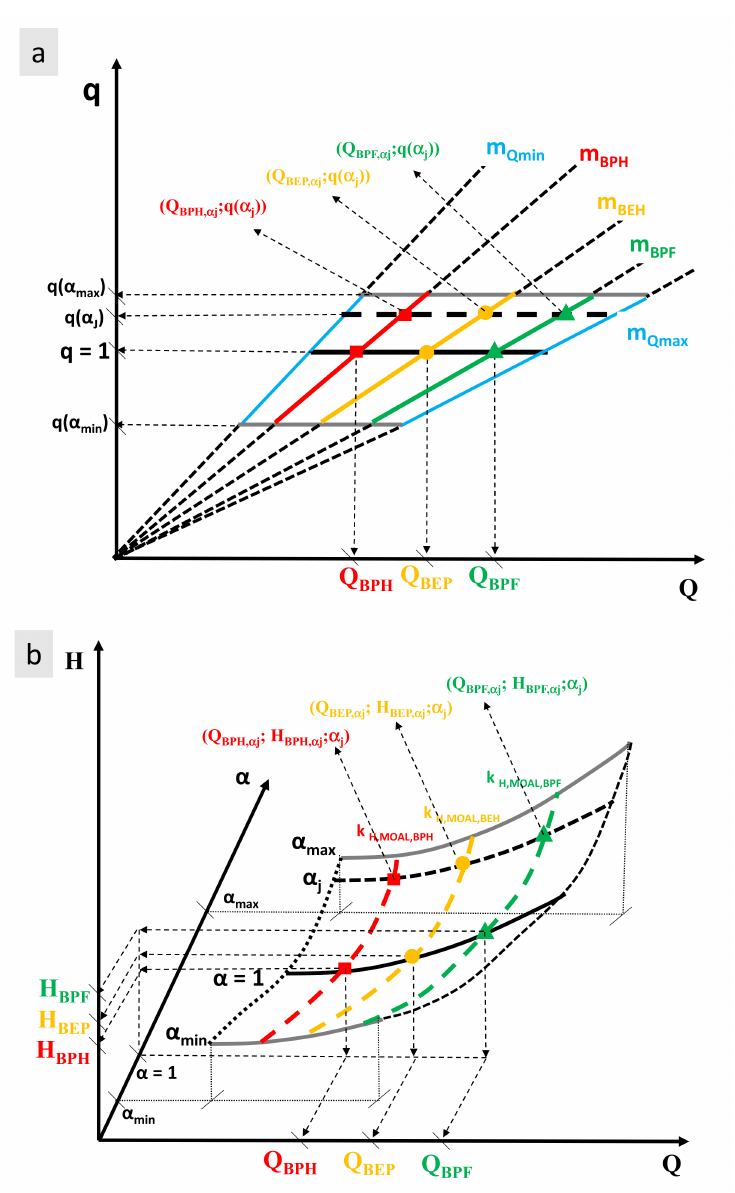
Figure 1. ( a ) m coefficient; ( b ) VOS